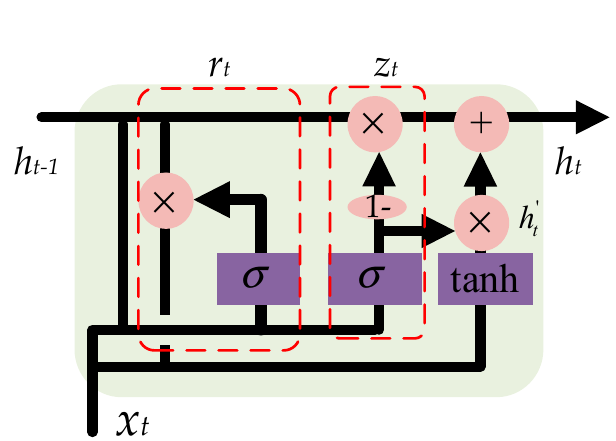
Figure 6. Structure of gated recurrent unit (GRU). The reset gate and the update gate take the previous output and the current input as the input.